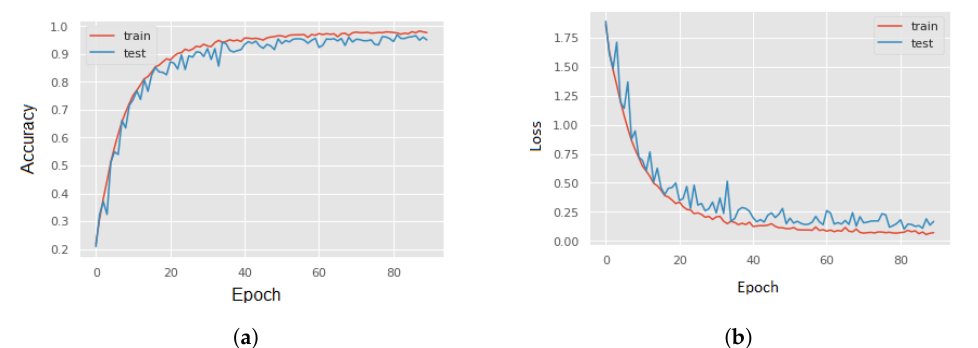
Figure 10. The Accuracy curve ( a ) and Loss curves ( b ) computed with the magnitude of 3D acceler- ations as input signal using multi-emotion classes (six emotions). The training and testing curves show a good fit, ruling out over-fitting.